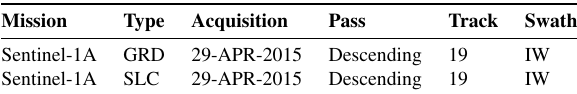
Table 1: Used Sentinel-1 data